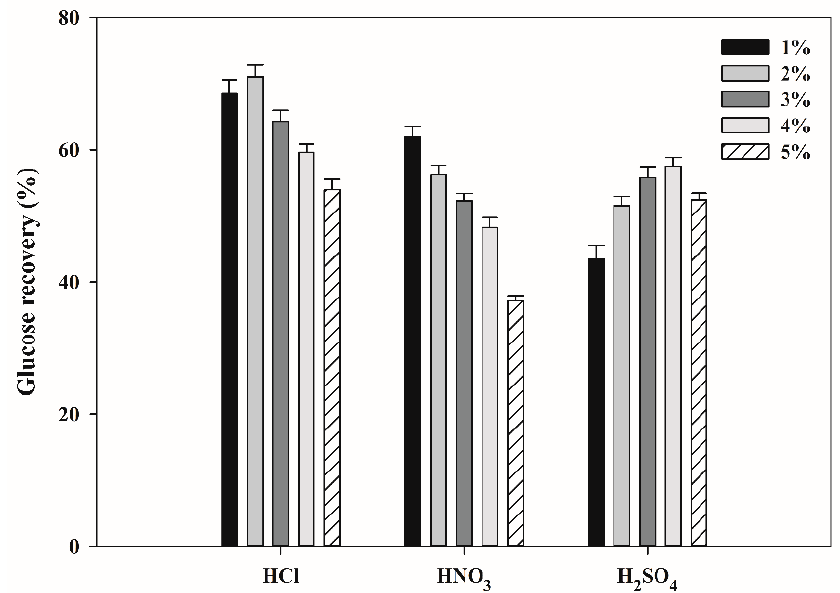
Figure 1. Effects of acid type and concentration on glucose recovery from whey powder.